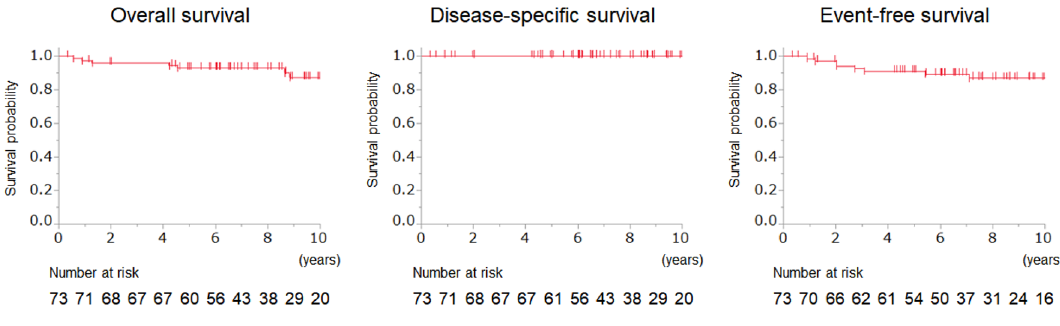
Figure 4. Overall, disease-specific, and event-free survival